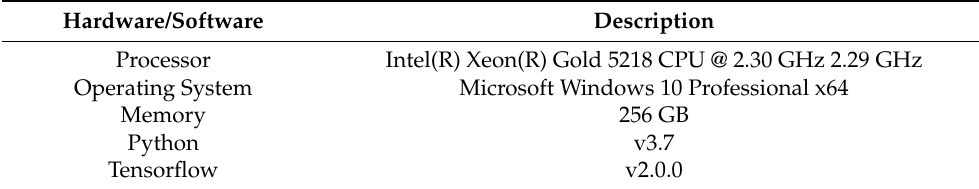
Table 2. Machine/software specifications.